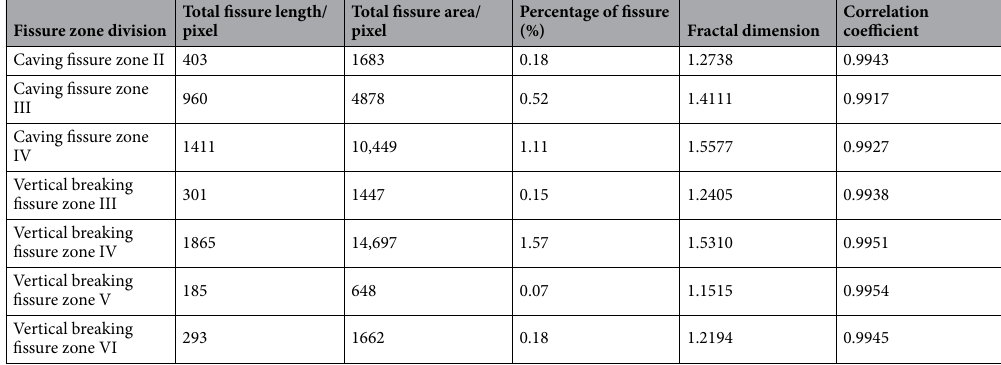
Table 3. Classification of fissure zone after the completion of 3-1 coal seam